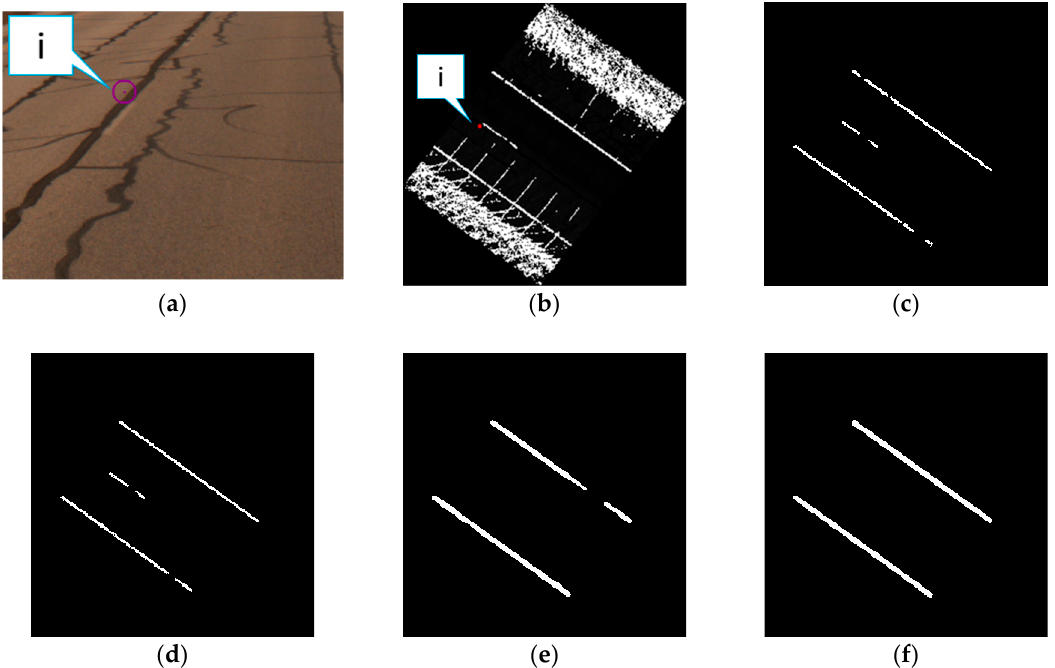
Figure 22. Yellow edge lane marking area in dataset 2: ( a ) RGB imagery of location i, ( b ) original intensity image, predicted lane marking images of ( c ) original intensity thresholding, ( d ) normalized intensity thresholding, ( e ) U-net model 1, and ( f ) U-net model 2.